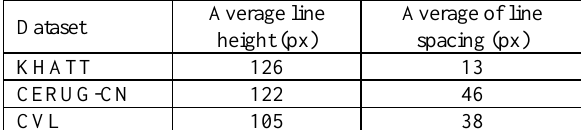
Table 1. Average values of line height and line spacing of the different